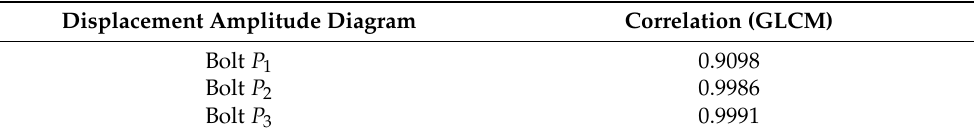
Table 5. Correlation of the GLCM of different vertical displacement amplitudes.